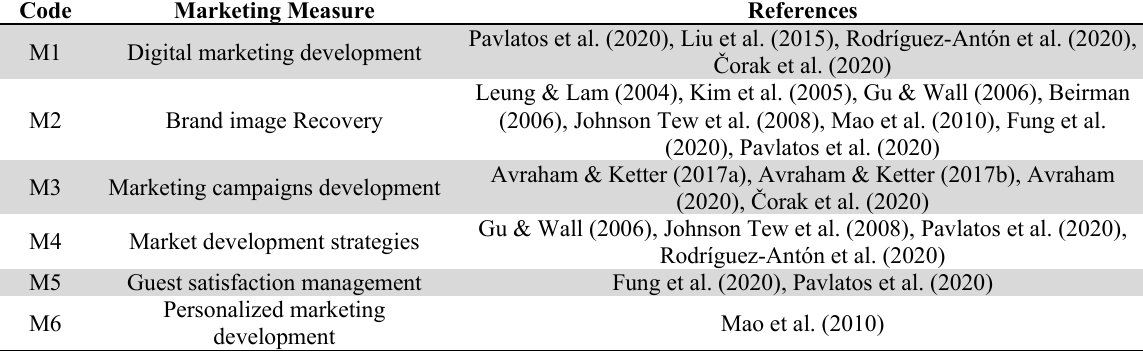
Marketing Measures for Tourism SMEs recovery from COVID-19